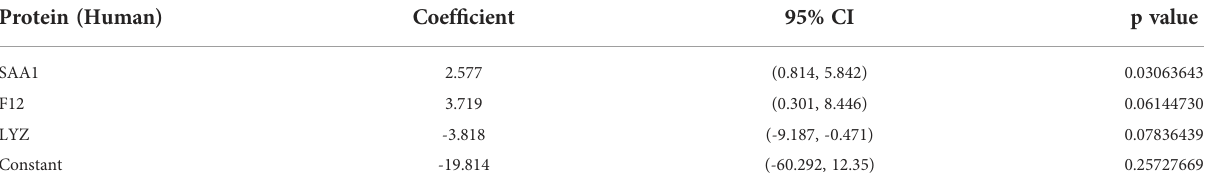
TABLE 6 The three-protein logistic regression classi fi er for diagnosis of advanced GAC. Protein (Human)